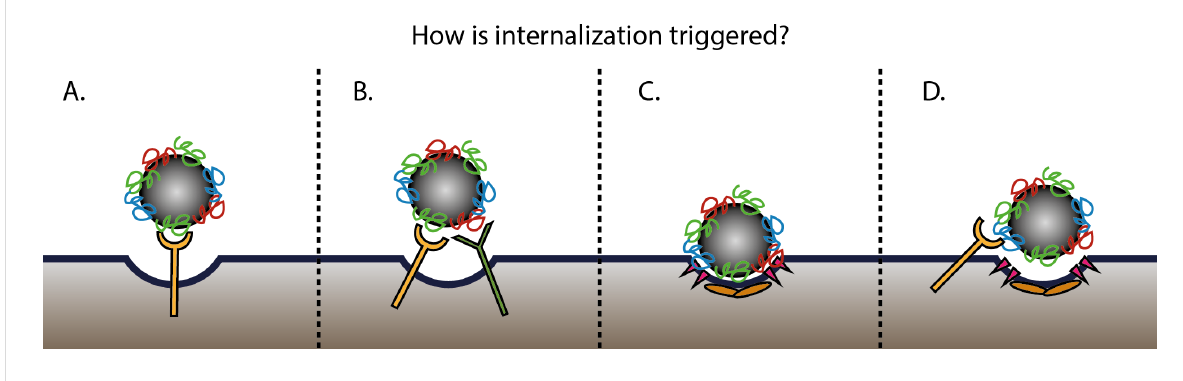
Figure 2: Scheme of possible scenarios that can occur at the cell surface, resulting in nanoparticle uptake. Nanoparticles or their corona can be recognized by one (A) or multiple types of receptors (B), and the recognition by receptors triggers nanoparticle uptake. Alternatively, the adhesion of the nanoparticle to the cell surface may induce internalization without receptor engagement (C) or the receptor is only involved in the initial adhesion of the nanoparticle, then uptake is triggered by different mechanisms, possibly induced by the nanoparticle itself (D).